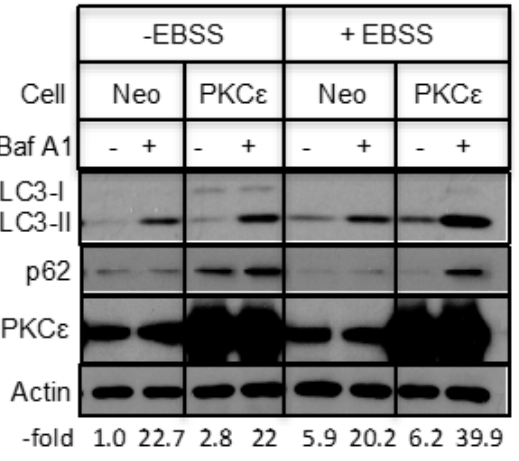
Figure 4. PKC ε overexpression enhanced starvation-induced autophagy. MCF-7/Neo and MCF-7/PKC ε cells were starved in EBSS in the presence or absence of Baf A1 and Western blot analyses were performed with indicated antibodies.